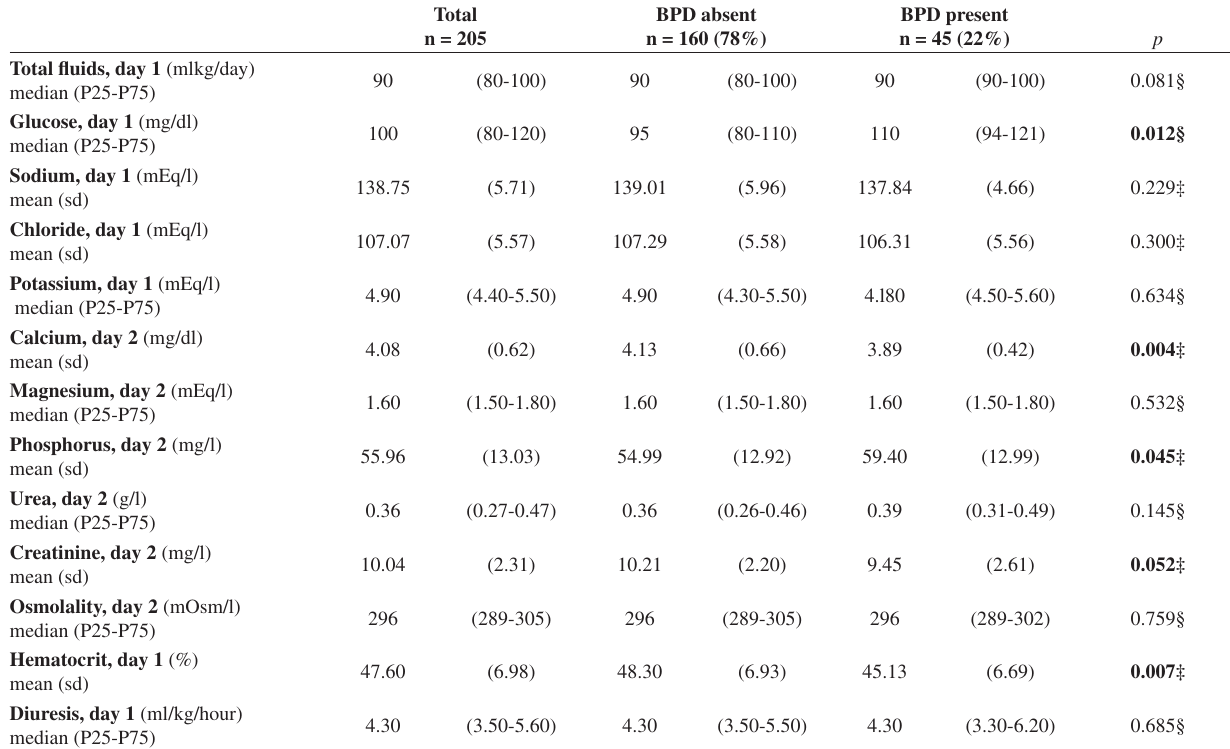
Table 4 - Clinical parameters obtained on the first or second day of